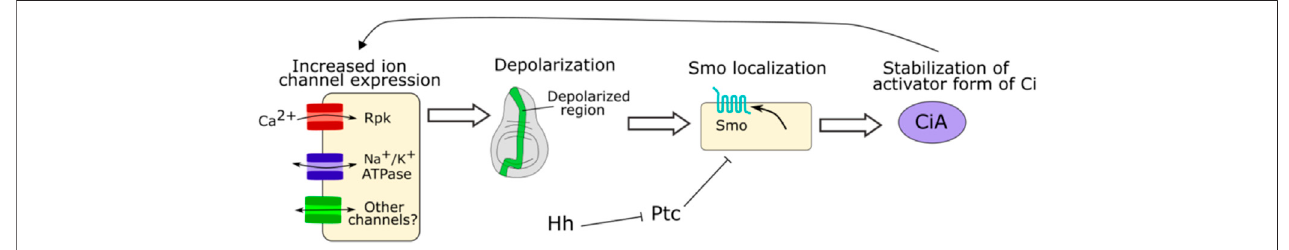
FIGURE 7 | Schematic of role of ion channel function in Hh signaling. In the Drosophila wing increased expression of Rpk and Na + /K + ATPase and other ion channels generates a depolarized region in the developing wing disc. This depolarization is necessary for proper Smo localization and downstream stabilization of Ci. In turn, Hh signaling regulates levels of Rpk and Na + /K + ATPase (Emmons-Bell and Hariharan,